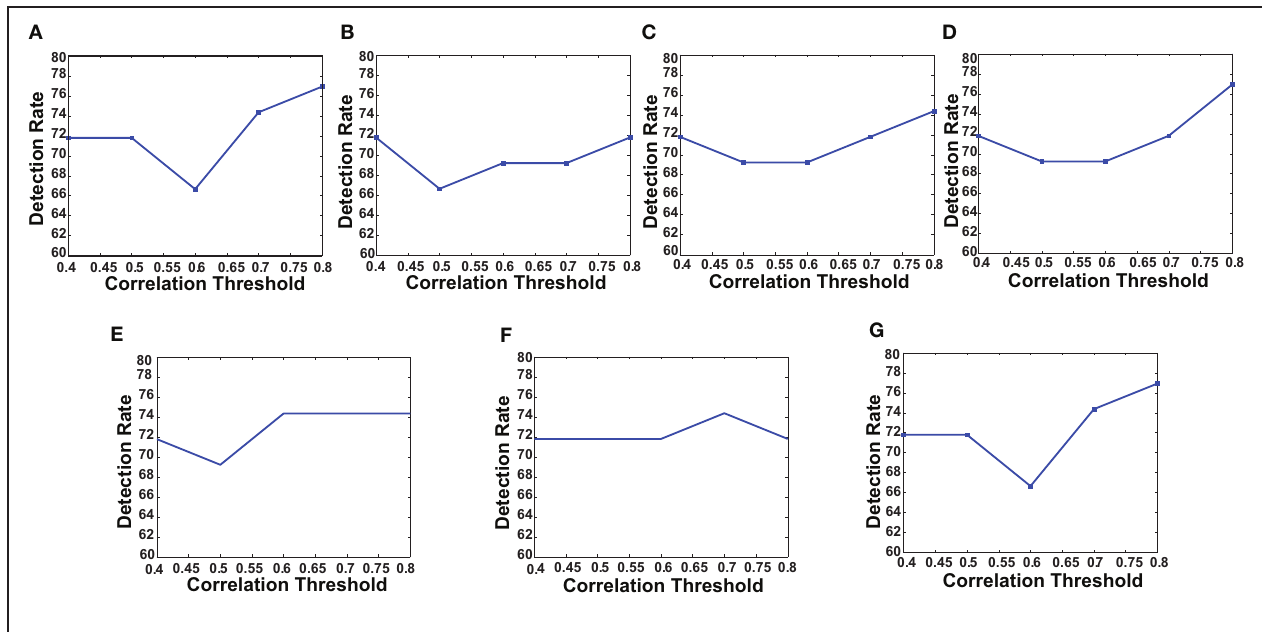
FIGURE 5 | The plots shows how detection rates for different network features change with correlation threshold. (A) Degree map positive correlations, (B) degree map negative correlations, (C) degree map absolute